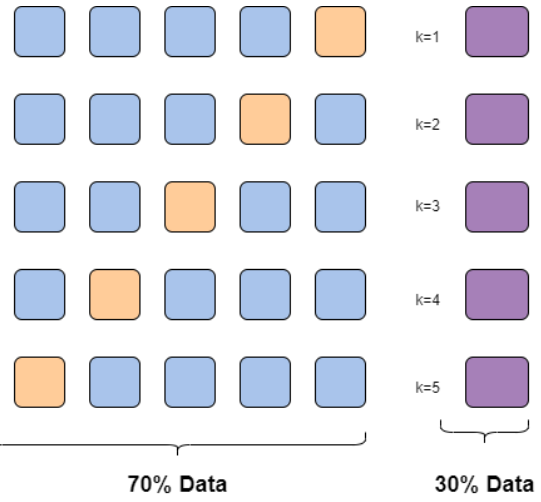
Figure 2. Exemplification of the cross-validation used in this